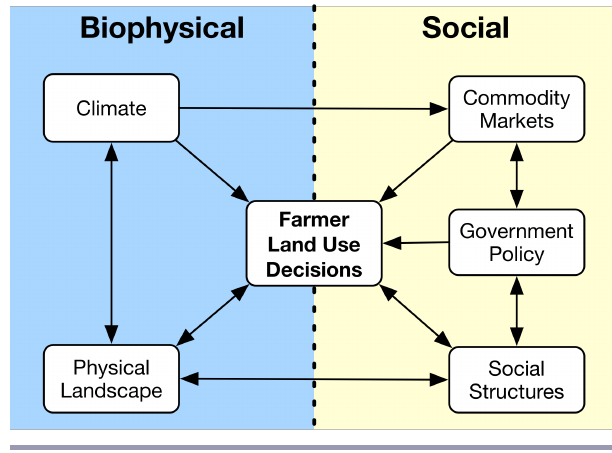
Fig. 1 . Simplified schematic of the social-ecological system in the Clear Creek Watershed. Farmer land use decisions provide a key coupling among biophysical and social structures and processes operating at a range of spatial and temporal scales. Arrows indicate direction of interactions and potential conduits for